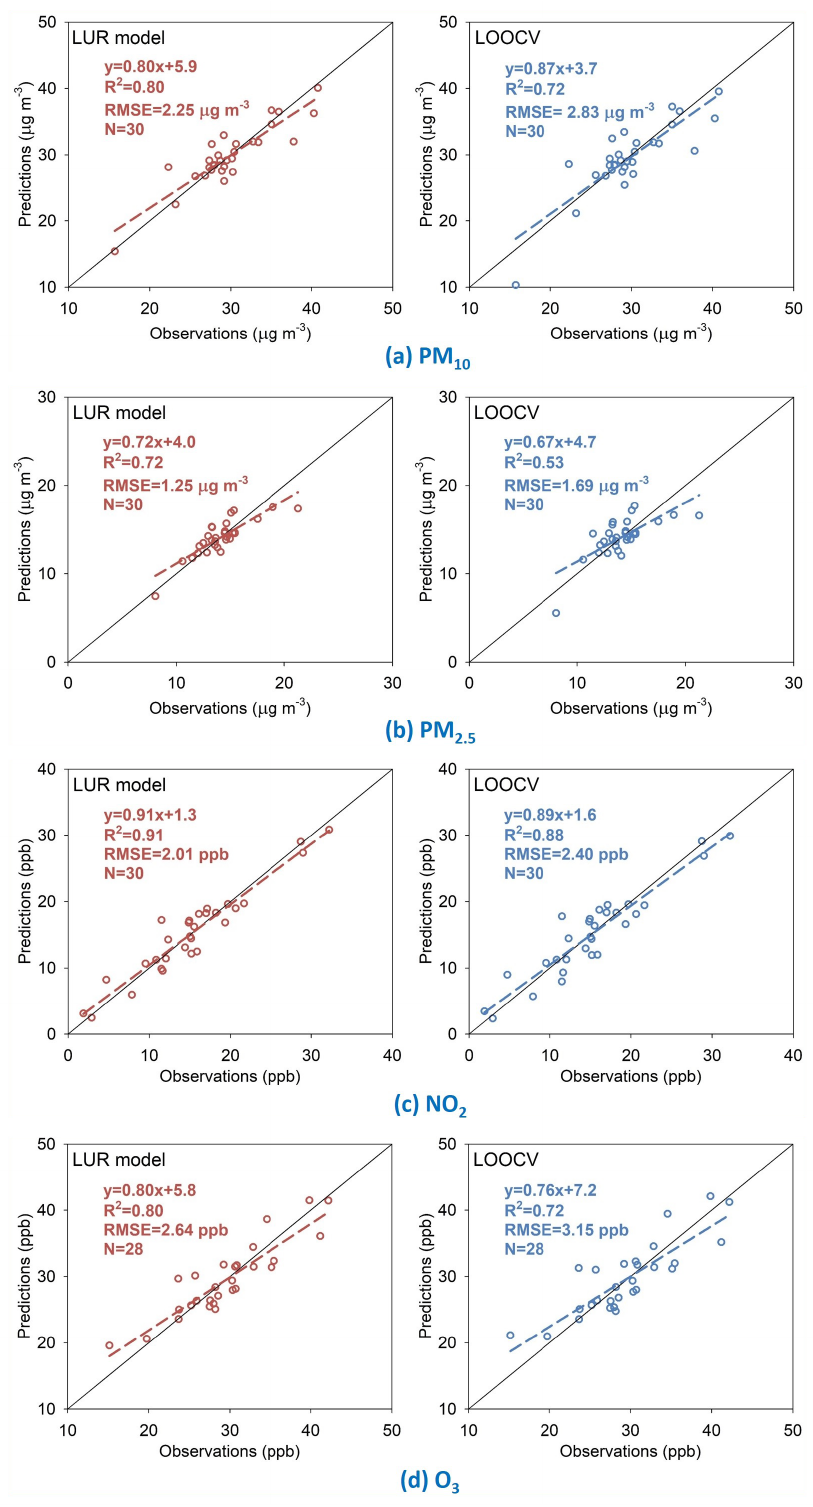
Figure 2. A comparison of LUR-predicted concentrations and observed concentrations of the studied air pollutants and the LOOCV-predicted concentrations and observed concentrations of the studied air pollutants. (a) PM 10 , (b) PM 2 . 5 , (c) NO 2 and (d) O 3 . N is the sample size, and the solid line is the 1 : 1